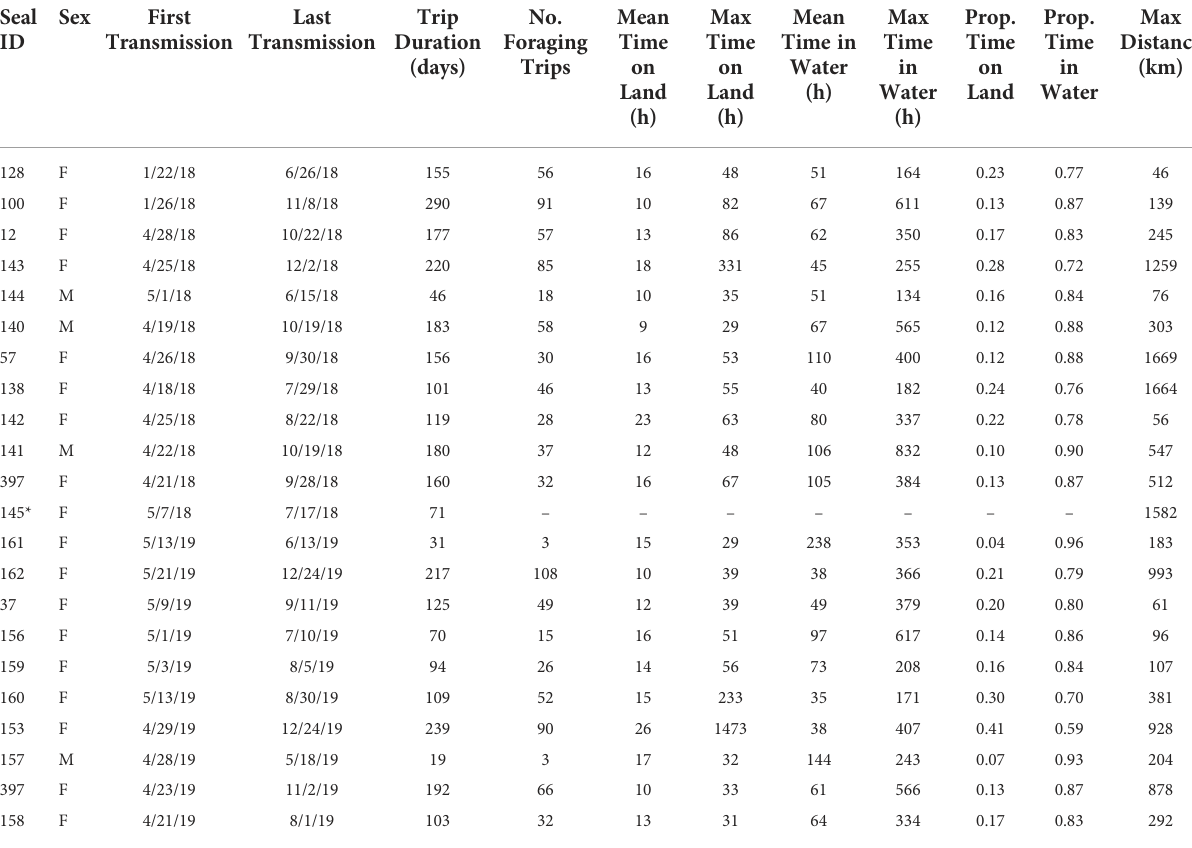
TABLE 2 Movement data for the leopard seals in this